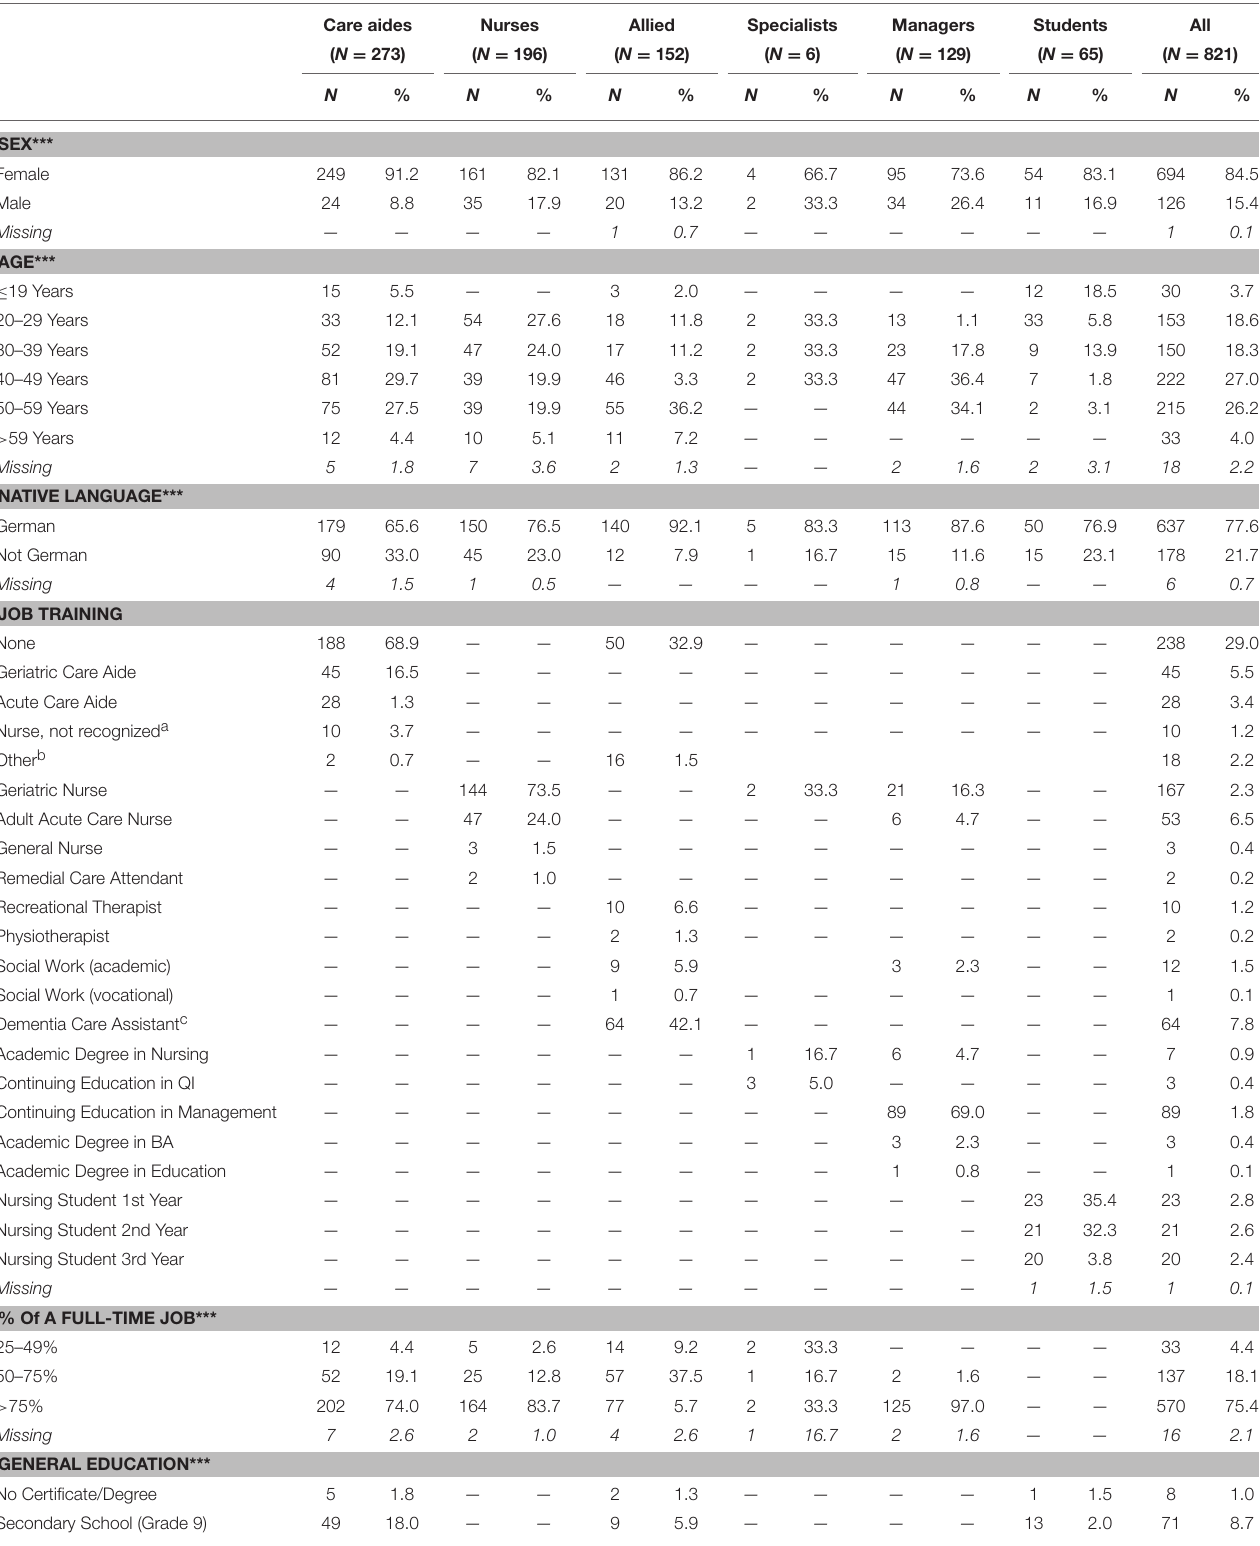
TABLE 5 | Socio-demographic characteristics of the included